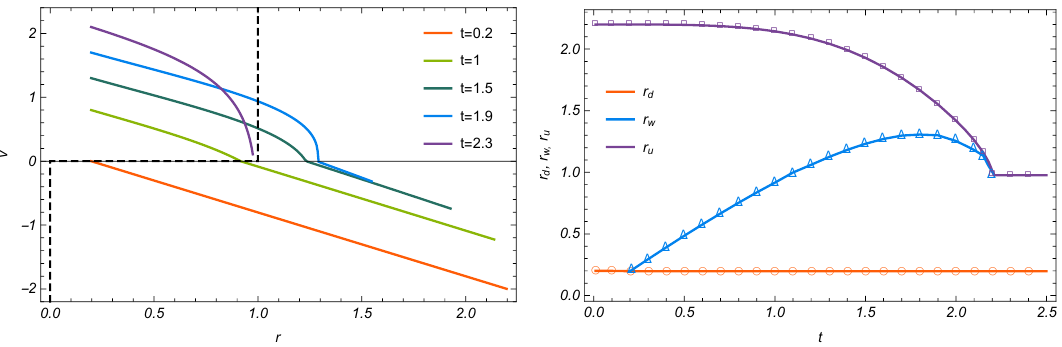
Figure 10 . Left : the pro(cid:12)le of v ( r ) for (cid:12)xed h = 0 : 4 ; ‘ = 2 and di(cid:11)erent values of boundary time. The dashed line indicates the apparent horizon. Right : time evolution of r d ; r w and r u . Clearly, r w always obeys the bound r d (cid:20) r w (cid:20) r u . The markers show the corresponding numerical results. Here we have set r h =